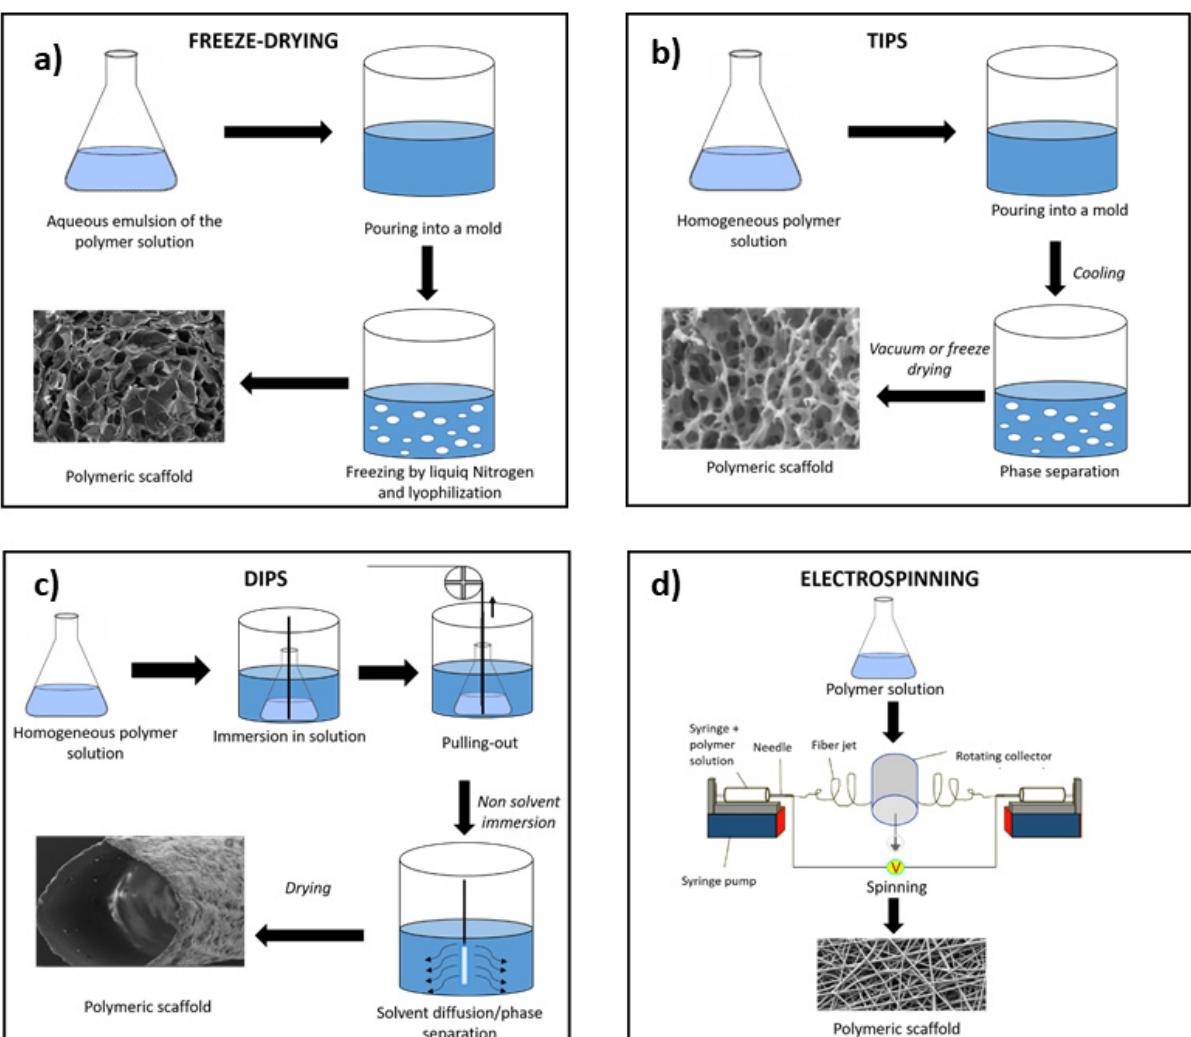
Figure 1. Schematic illustration of the solution-based fabrication process of scaffolds: ( a ) freeze-drying, ( b ) thermally induced phase separation, ( c ) diffusion induced phase separation, and ( d ) electrospinning.